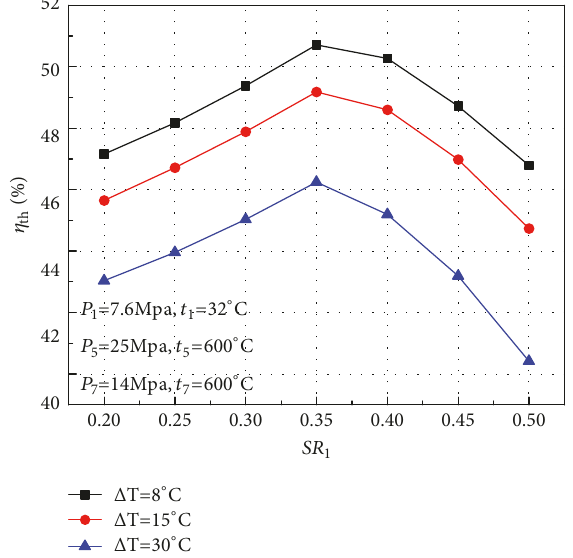
Figure 4: Effects of SR 1 on cycle efficiency at different terminal temperature